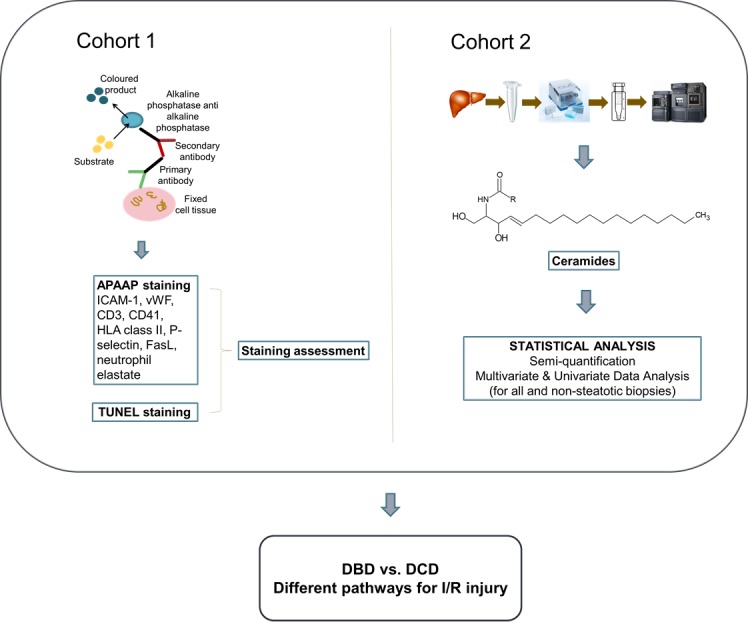
Study design.Two independent cohorts of immunohistochemistry and targeted lipids analysis found that DBD and DCD liver allografts have different pathways for I/R injury.